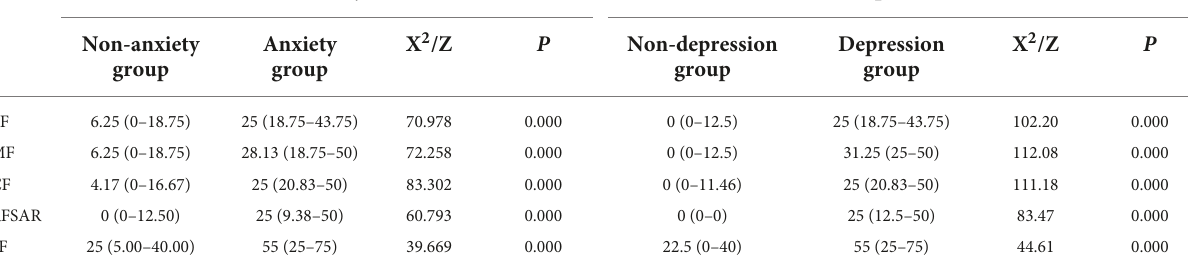
TABLE 5 Univariate analysis of fatigue factor among anxiety and